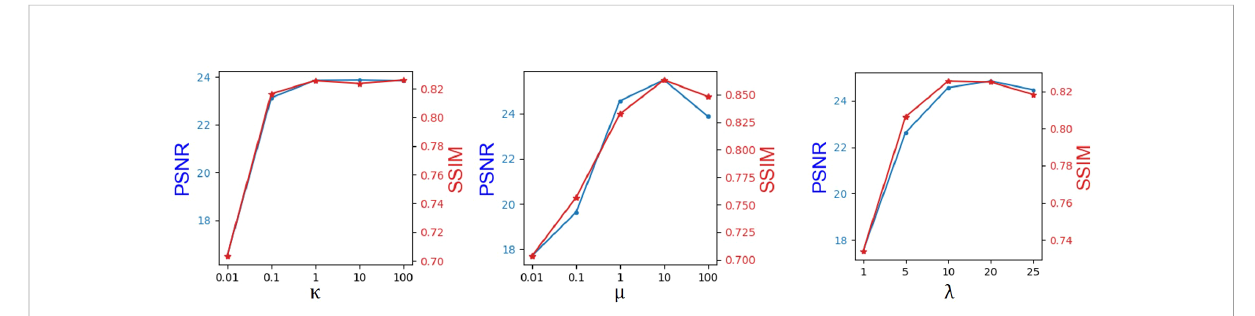
FIGURE 2 Hyperparameter selection results in the objective